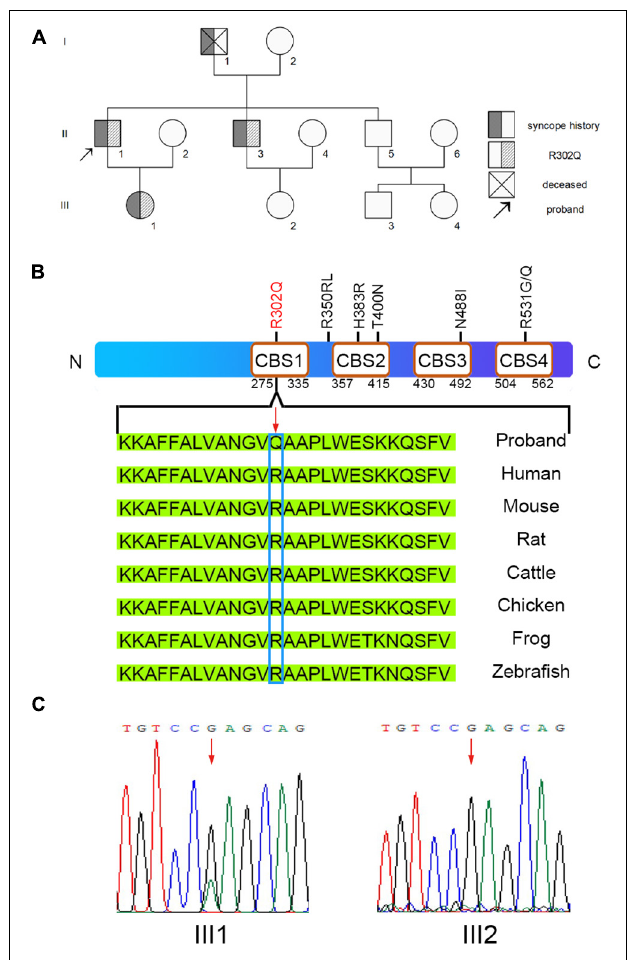
FIGURE 2 | Sequence analysis for the pedigree. (A) Overview of the clinical symptoms for the pedigree. The proband is indicated by the black arrow. (B) The missense mutation PRKAG2 -R302Q was found in the proband. (C) A heterozygous G > A transition at nucleotide 905 of PRKAG2 was confirmed by Sanger sequencing. A change in the amino acid sequence is highlighted by the red